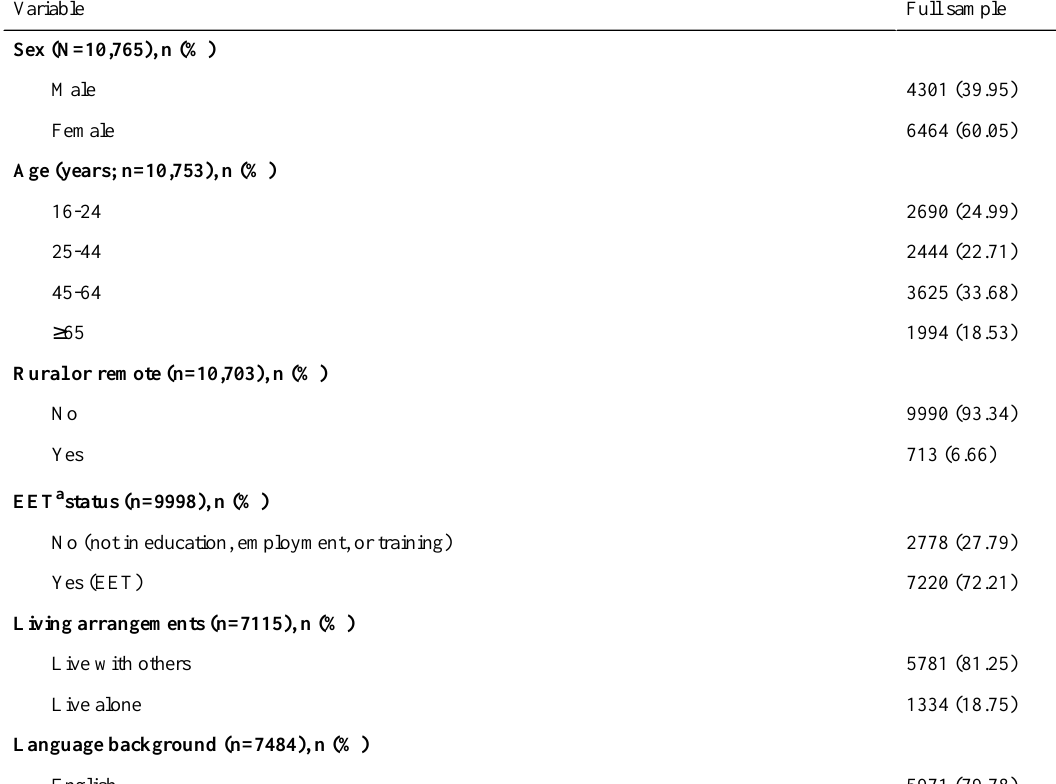
Table 1. Participants’sociodemographics by